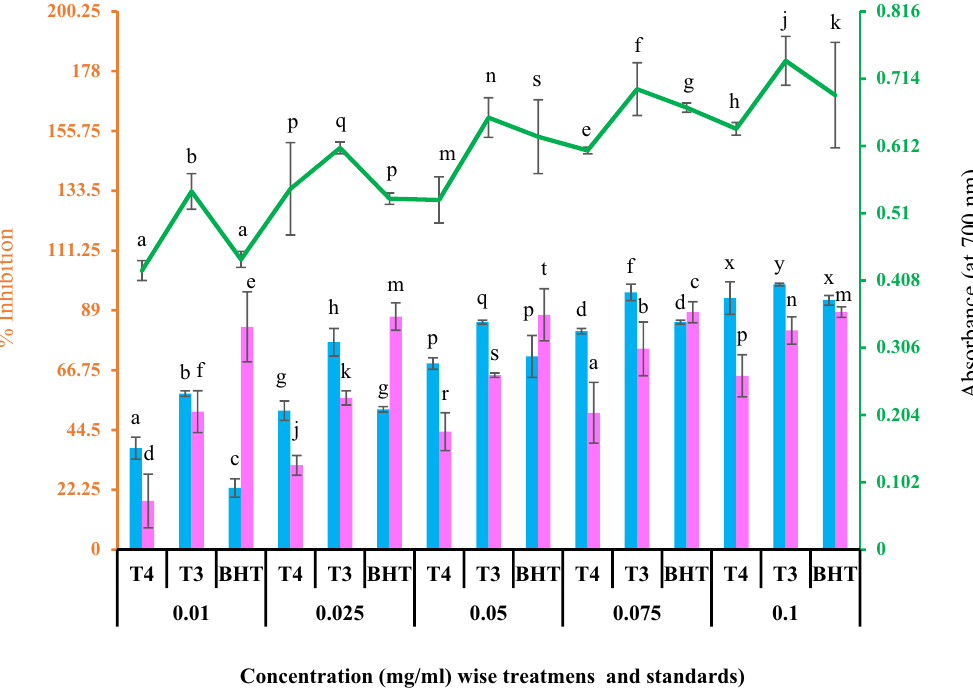
Figure 2. Showing the changes in DPPH, H 2 O 2 free radical scavenging activities and reducing power assay of C. brevifolius extracts grown in crude oil contaminated soil and control soil. Values are mean, n = 3, error bars stand for SD. Significant differences of the values for a particular parameter at a particular concentration for different treatments and standard are indicated by different letters (ANOVA, LSD test, P ≤ 0.05 ). Black axis-for concentration wise treatments and standards, Brown axis-for DPPH and H 2 O 2 free radical scavenging activity, Green axis-for reducing power assay.T4- Non-contaminated soil + Cyperus brevifolius, T3- Crude oil contaminated soil + Cyperus brevifolius , BHT- Butylated hydroxytoluene.